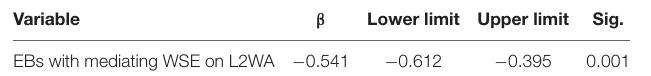
TABLE 14 | Bootstrap estimate of indirect effect with mediating WSE. Variable β Lower limit Upper limit Sig. EBs with mediating WSE on L2WA − 0.541 − 0.612 − 0.395 0.001